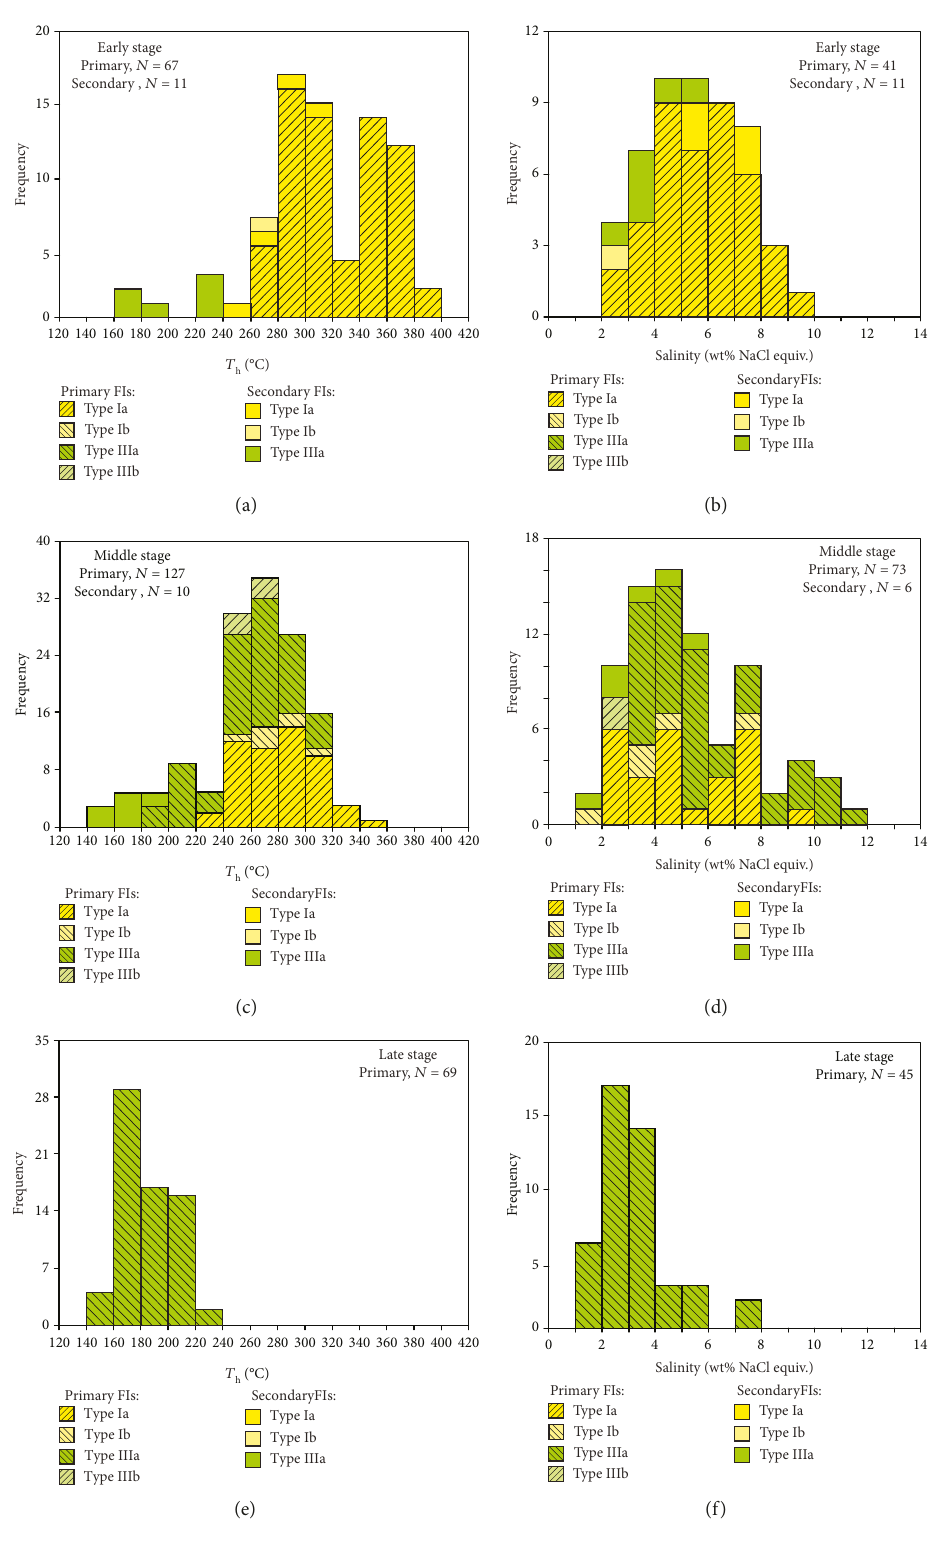
Figure 9: Histograms of total homogenization temperatures ( T ) and salinities of fl uid inclusions in di ff erent stages of Xiejiagou gold deposit. h (a) Homogenization temperatures for primary and secondary FIs in early-stage quartz; (b) salinity for primary and secondary FIs in early- stage quartz; (c) homogenization temperatures for primary and secondary FIs in middle-stage quartz; (d) salinity for primary and secondary FIs in FIs of middle-stage quartz; (e) homogenization temperatures for type IIIa FIs of late-stage quartz; (f) salinity for type IIIa FIs of late-stage